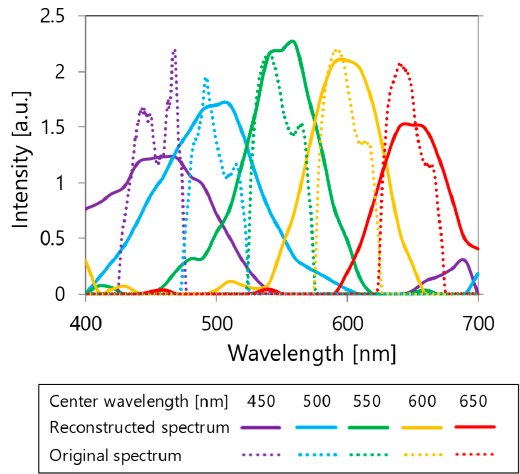
Figure 11. Spectral reconstruction.